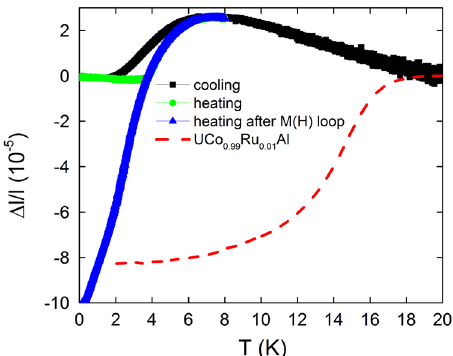
Fig. 4 Temperature dependence of thermal expansion of UCo 0.995 R- u 0.005 Al ( symbols ) and UCo 0.990 Ru 0.010 Al ( dashed line ). All measure- ment are done along the c -axis at zero fi eld, measurement denoted by blue triangles was done after the crystal was fully magnetized at 100